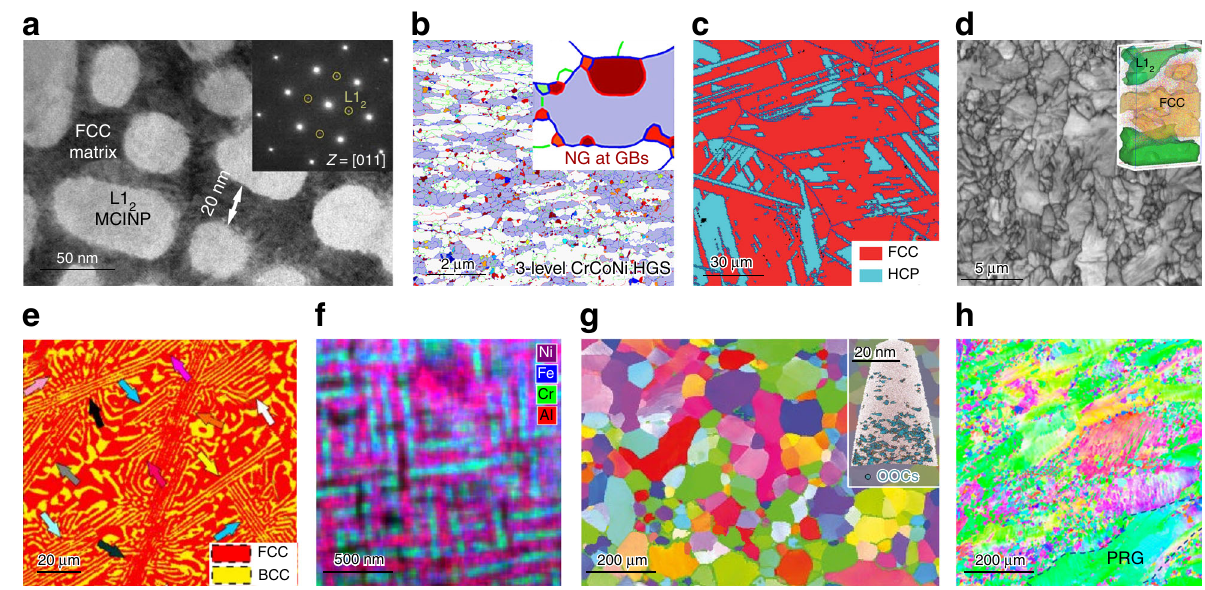
Fig. 2 Example microstructures of highly heterogeneous HEAs. a Multicomponent intermetallic nanoparticles (MCINP)-strengthened FCC (FeCoNi) 86 - Al 7 Ti 7 (Ll 2 ) HEA (from ref. 26 . Reprinted with permission from AAAS). b Heterogeneous grain structured (HGS) CrCoNi MEA 23 . c Transformation-induced plasticity (TRIP) dual-phase Fe 50 Mn 30 Co 10 Cr 10 HEA 33 . d Al 0.5 Cr 0.9 FeNi 2.5 V 0.2 HEA with ordered Ll 2 precipitates and disordered FCC matrix 38 . e Dual- phase eutectic lamellae AlCoCrFeNi 2.1 HEA 36 . f Al 1.3 CoCrCuFeNi HEA of Al – Ni-enriched matrix with Cr – Fe-enriched plates 37 . g BCC single-phase TiZrHfNb HEA. Inset: (TiZrHfNb) 98 O 2 HEA. OOCs ordered oxygen complexes 22 . h Hierarchical features infused HGS HEA, consisting of partially recrystallized grains of large size and completely recrystallized grains of fi ne size 39 .